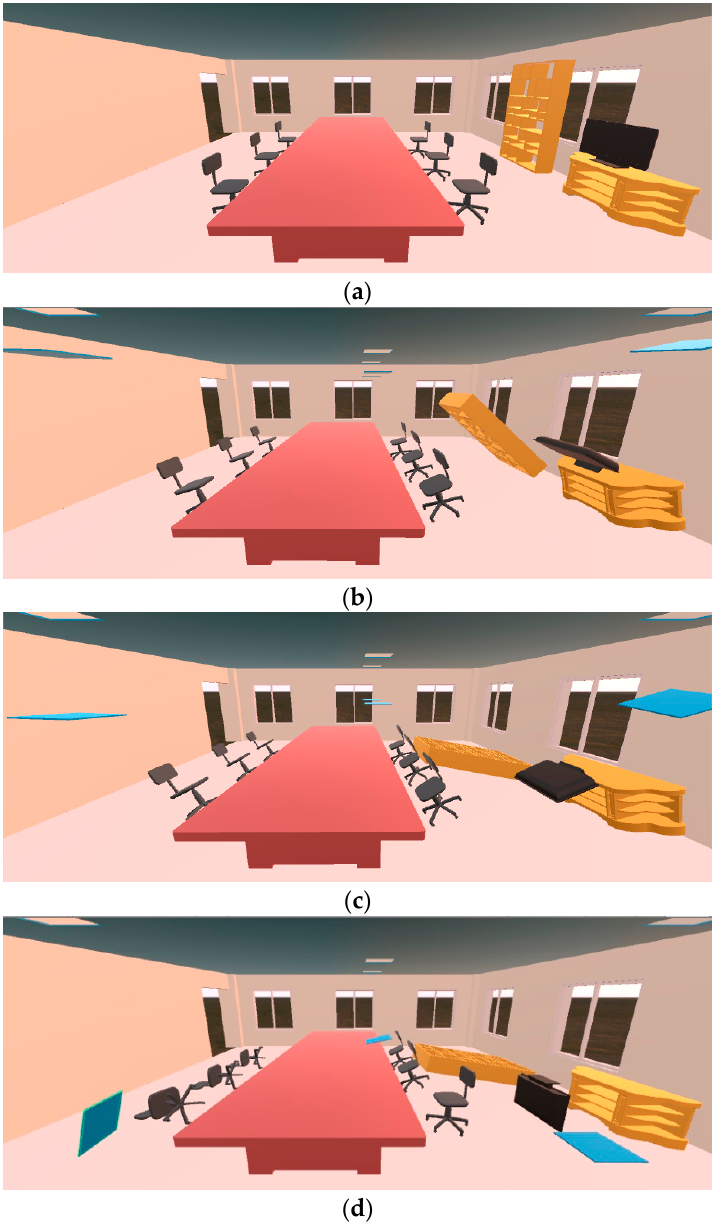
Figure 12. Integrated indoor earthquake scene, ( a ) original scene; ( b ) furniture overturns; ( c ) ceiling titles fall; ( d ) ceiling titles fall to the floor.